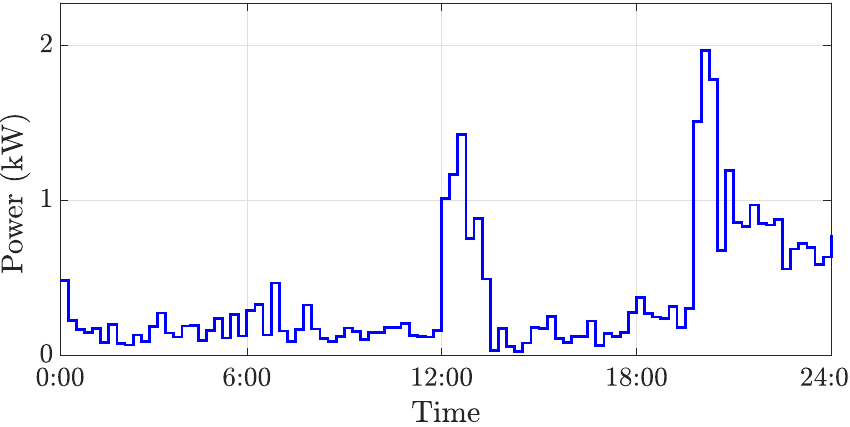
Figure 3. Exemplary profile for the energy consumption of a household.